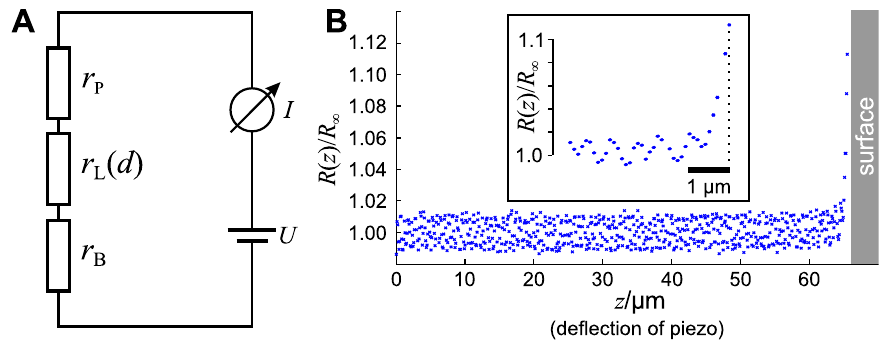
Figure 2. ( A ) Circuit diagram of a SICM. The current flows through the three resistors r r ( d ) and r ( d ) depends on the distance d between sample and probe . The resistance of r L B L and is utilized to determine the topography; ( B ) Typical resistance-distance or approach curve. After an approximately steady resistance at large tip-sample distances, the relative resistance R ( z ) /R increases with when the tip approaches the sample surface. The inset ∞ shows a magnification of the last